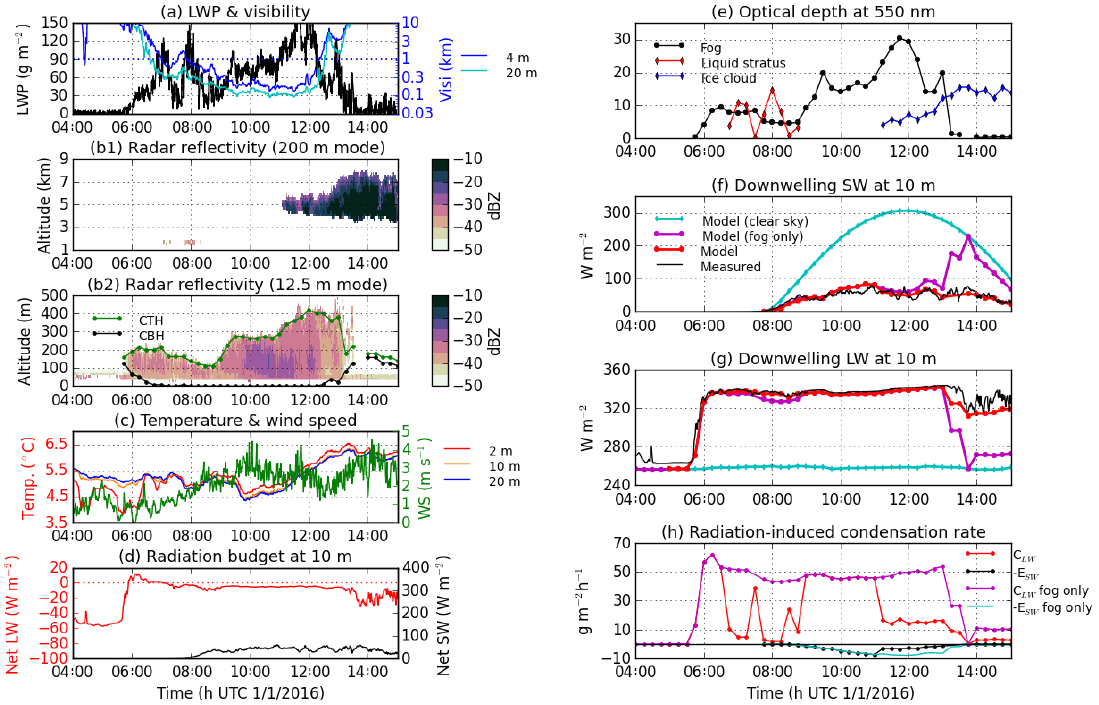
Figure 7. Case study of the fog event on 1 January 2016, when clouds appeared above the fog. Panels are the same as in Fig. 3, with a few additions. In (b) , there are two panels, the upper one showing the reflectivity from the 200m mode of the radar and the lower one that of the 12.5m mode. In (e) , the optical depths of the cloud layers above the fog are also indicated, and in (f–h) the results obtained when including only the fog (and not the higher clouds) have been